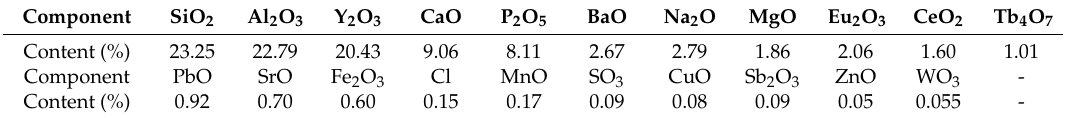
Table 1. Main chemical composition of the waste fluorescent powder (wt